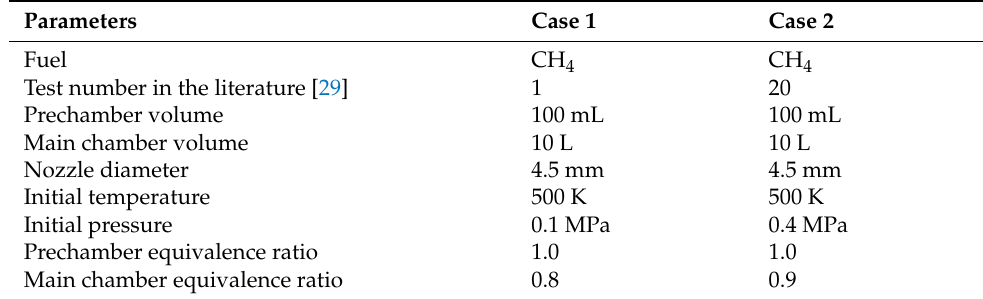
Table 2. The conditions of the validation cases.